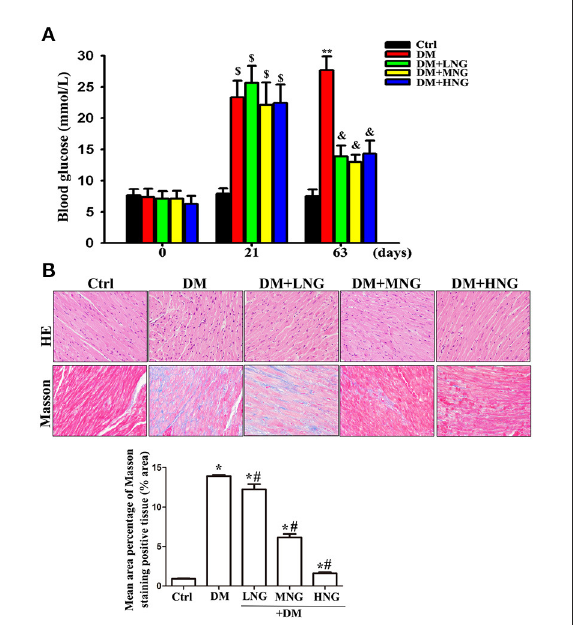
FIGURE1 NG improves hyperglycemia and pathologic damage to cardiac tissue in diabetic mice. (A) Blood glucose of mice from different treatments. Data are presented as the mean ± SD ( n = 6). $ P < 0.05 vs. corresponding groups in 0 day; ** P < 0.05 vs. Ctrl group in 63 days, & P < 0.05 vs. DM group in 63 days. (B) Representative images of HE or Masson staining for each group,